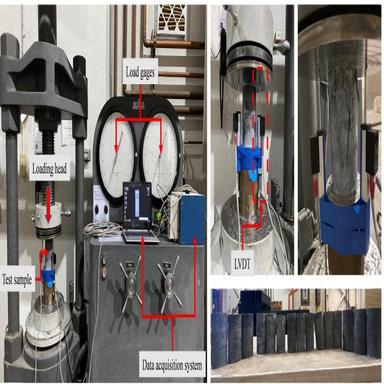
Test setup of the compressive stress–strain behavior test.